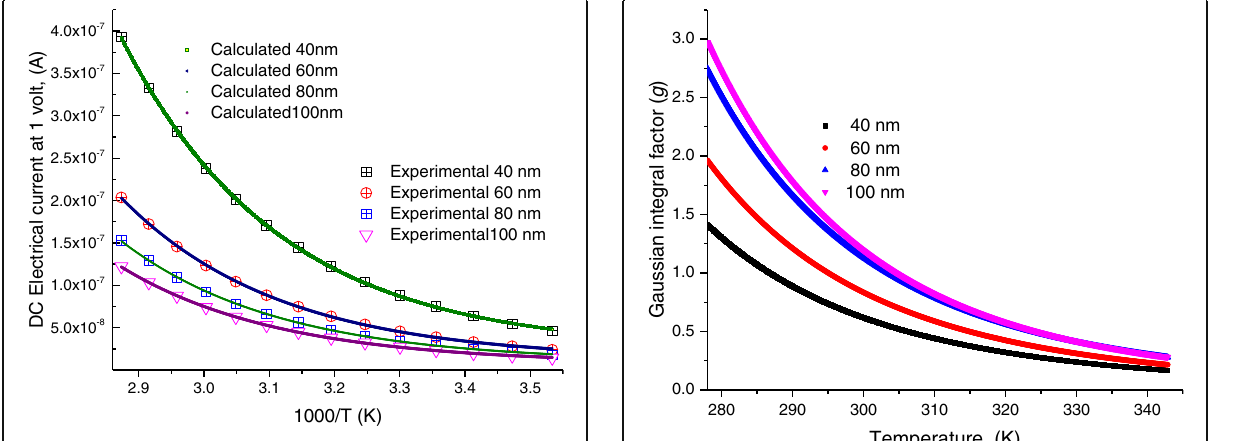
Fig. 7 DC-current as a function of temperature for different lengths of DNA molecule. Symbols represent experimental data, and continuous lines are calculated data after Eqs. (5 – 7)